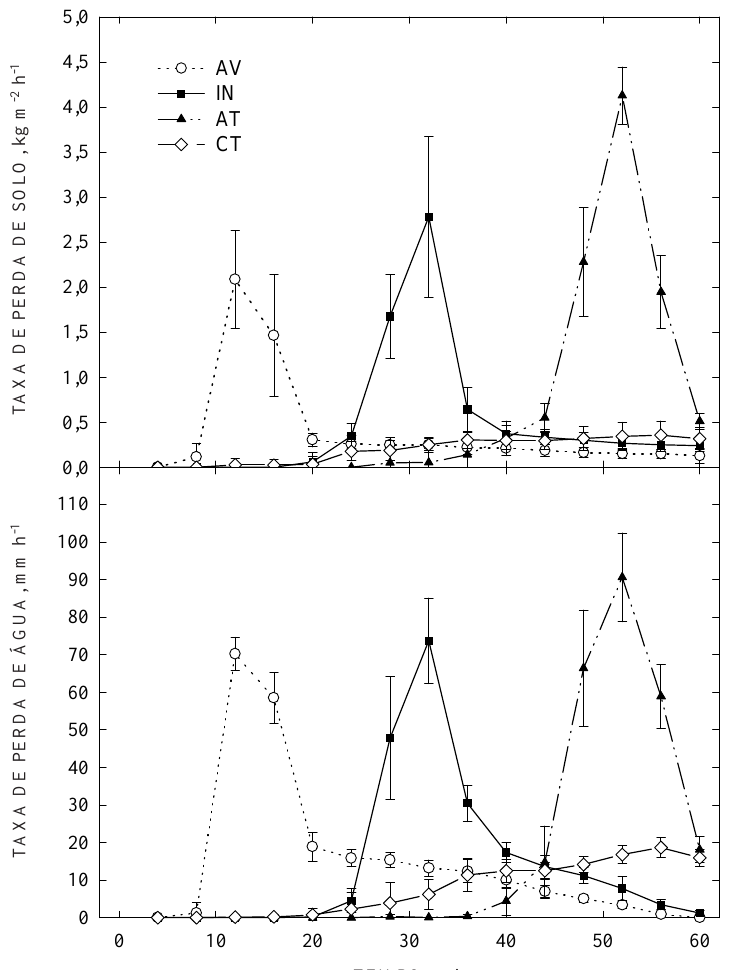
Figura 3. Taxas de perdas de solo e água nos padrões de chuva avançado (AV), intermediário (IN), atrasado (AT) e constante (CT), observadas durante a chuva proposta, com intervalo de 95% de